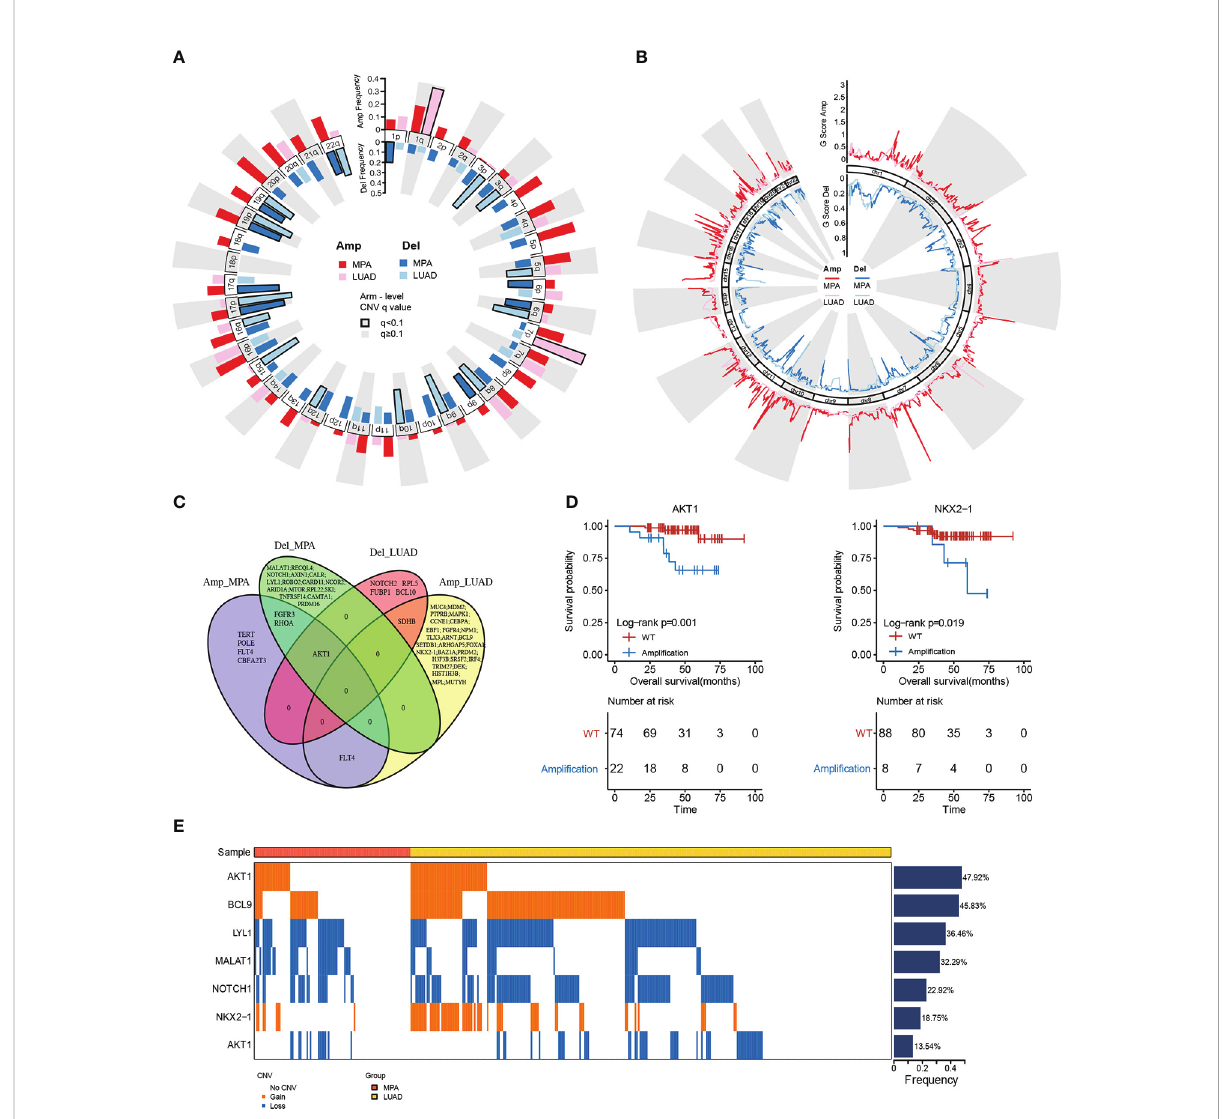
FIGURE 2 Genomic copy number alterations and statistics of driver genes in hotspot mutation regions. (A) , Chromosome arm-level CNV frequencies in MPA and LUAD cohorts. Dark red represents the CNV ampli fi cation result of MPA, light red represents the CNV ampli fi cation result of LUAD. Dark blue represents the CNV censored result of MPA, and light blue represents the CNV censored result of LUAD. Columns with black borders indicate chromosome arms that have been signi fi cantly ampli fi ed or censored. (B) , Focal-level CNV across chromosomes 1 – 22, with GISTIC FDR q values on the x-axis. Dark red represents the CNV ampli fi cation result of MPA, light red represents the CNV ampli fi cation result of LUAD, dark blue represents the CNV censored result of MPA, and light blue represents the CNV censored result of LUAD. (C) , Venn diagram of driver gene overlap in the signi fi cant copy number region between MPA and LUAD. (D) , Survival analysis results of the driver genes above the copy number region in MPA. (E) , Differences in CNV of the driver genes shared by MPA and